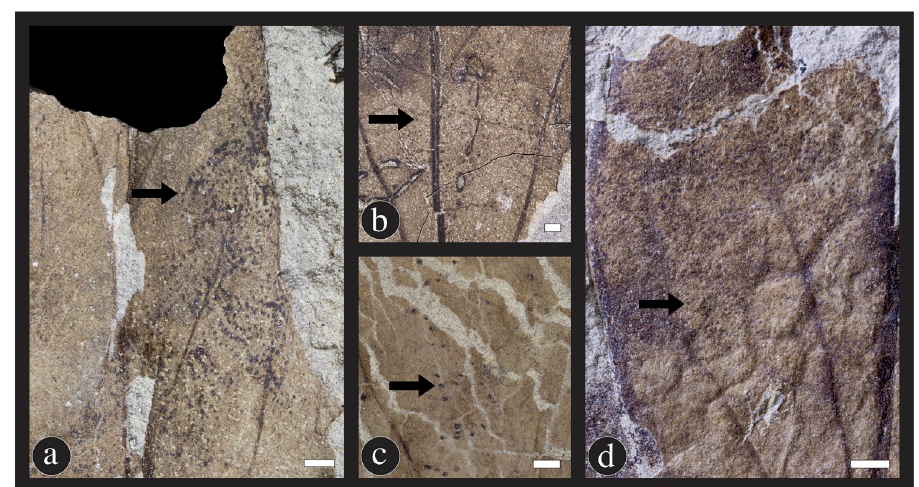
Fig 12. Insect damage caused by piercing-and-sucking insects. (A) DT219; This damage type (DT) consists of two mirrored lines of puncture marks, which are potentially made by mandibles (DMNH 39724). Additional evidence of piercing-and-sucking insects comes from circular, concave puncture marks DT46 (B) (DMNH 41590); and circular, convex puncture marks DT47 (C) (DMNH 41588). A second new piercing and sucking damage type (D) involves many puncture marks across large portions or the entirety of the leaf lamina (DT330) (DMNH 41569). Scale bars = 1 mm; arrows indicate a single puncture for clarity.